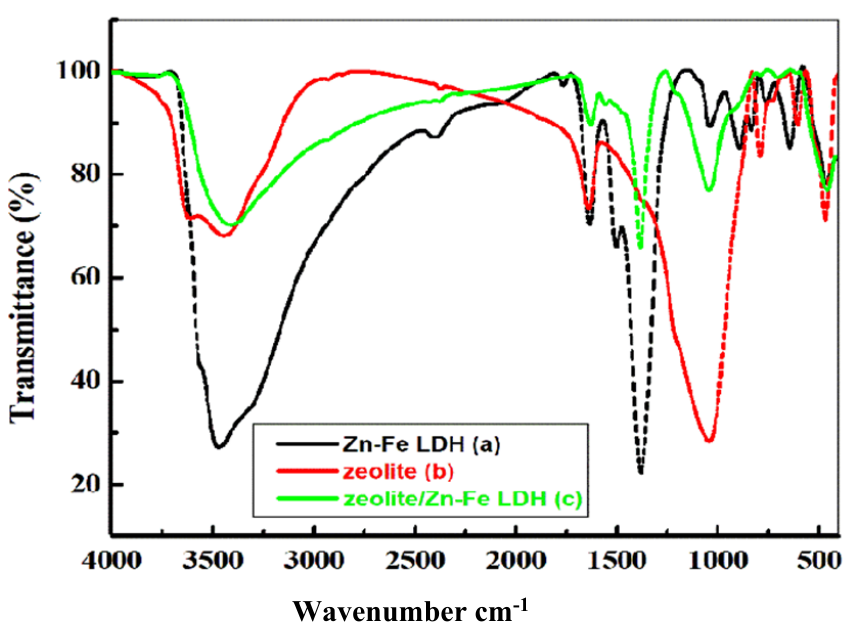
Figure 3. ( a – c ) FT-IR spectra patterns of Zn-Fe LDH, zeolite and zeolite/Zn-Fe LDH composite. The morphology of the synthesized materials was studied via FE-SEM (Figure